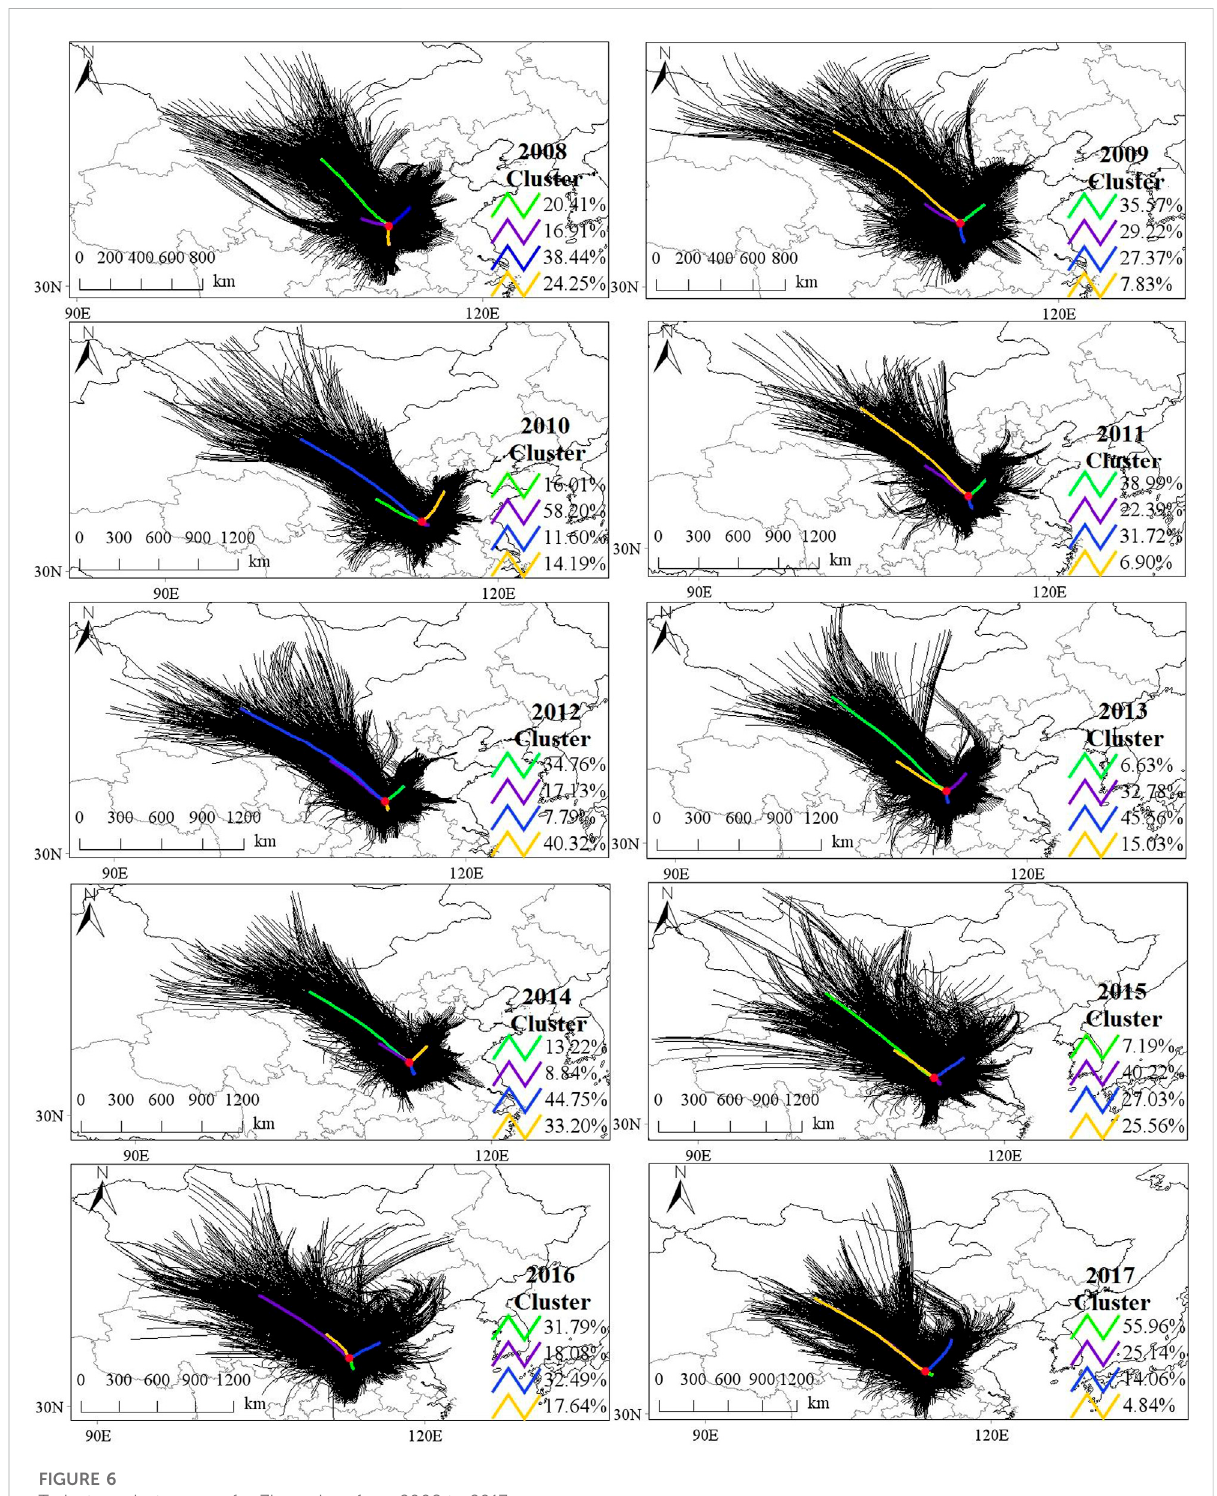
FIGURE 6 Trajectory cluster maps for Zhengzhou from 2008 to